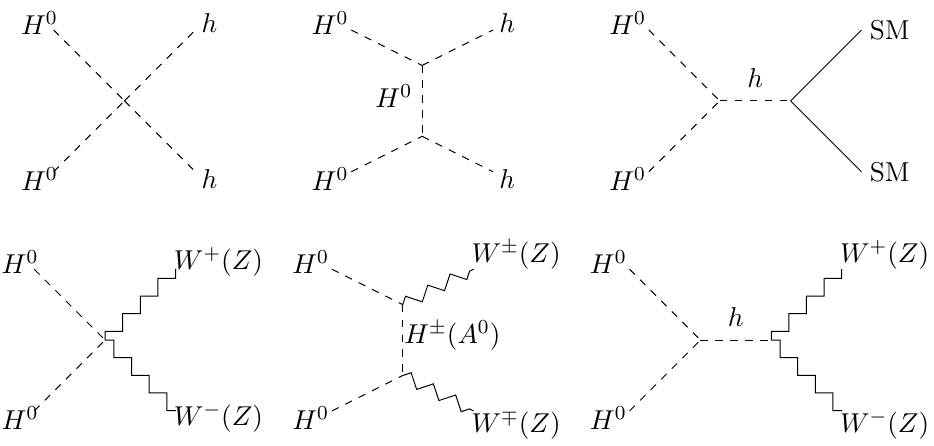
Figure 6 . Annihilation processes of IDM ( H 0 ) to SM particles. SM in the top right graph stands for W (cid:6) ; Z; h and SM